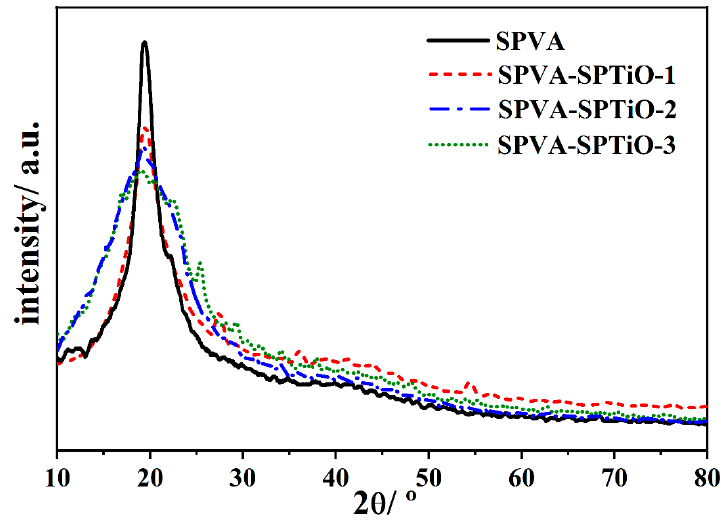
Figure 11. XRD patterns of the doped and undoped membranes. Table 3. Ion exchange capacity (IEC), oxidative stability, borohydride permeability and ionic conductivity of the fabricated membranes and Nafion ® 117 [37,38].